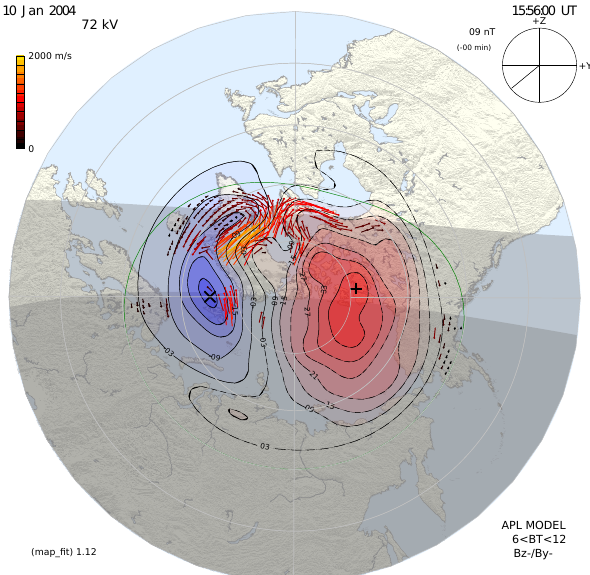
Fig. 7. SuperDARN spatial convection plot for 15:56UT. We notice the presence of crescent-shaped dusk-side convection cell and flow channel FC 2 over Svalbard (76–80 ◦ MLAT/18:00MLT).